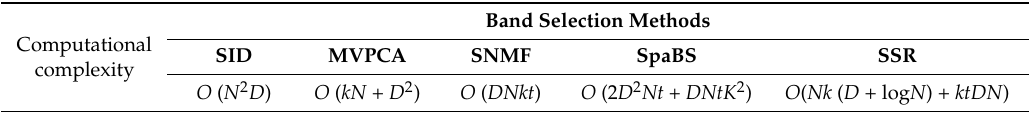
Table 5. The contrast in computational complexity of SSR and the four other